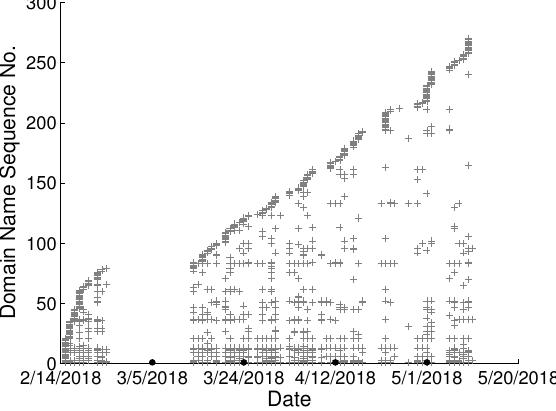
Figure 5. Domain names visited in chronological order from user D in our lab. Finally, the abnormal scores of different test time periods for one user derived from the IUAD submodel can be represented as a vector: Z IUAD = ( z t ) [ k , n ] is the set of indexes for different test time